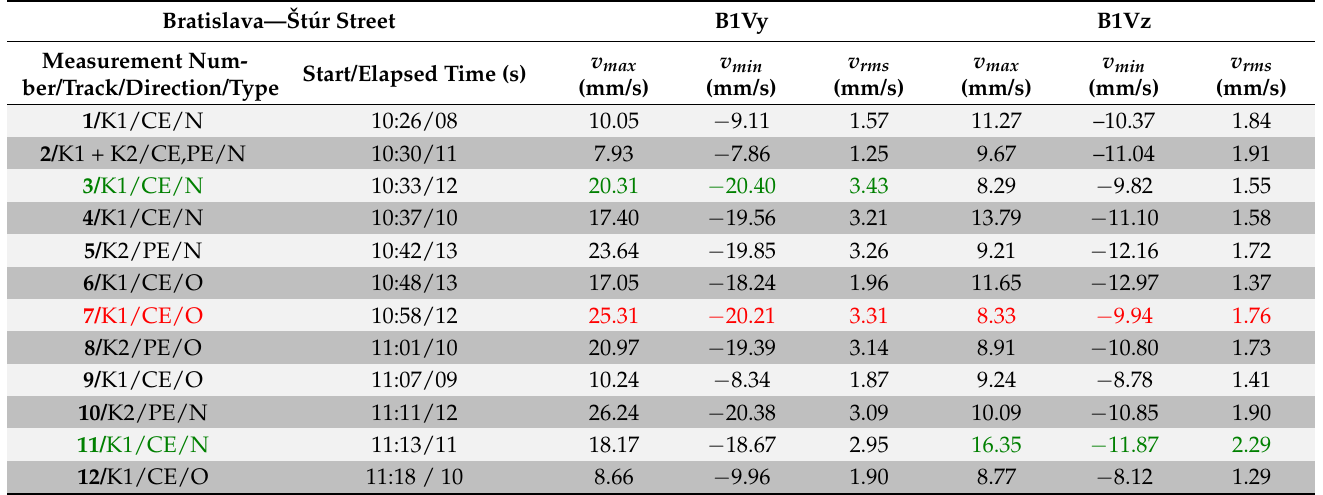
Table 4. Amplitude characteristics from vibration velocity time records at points B1Vz and B1Vy